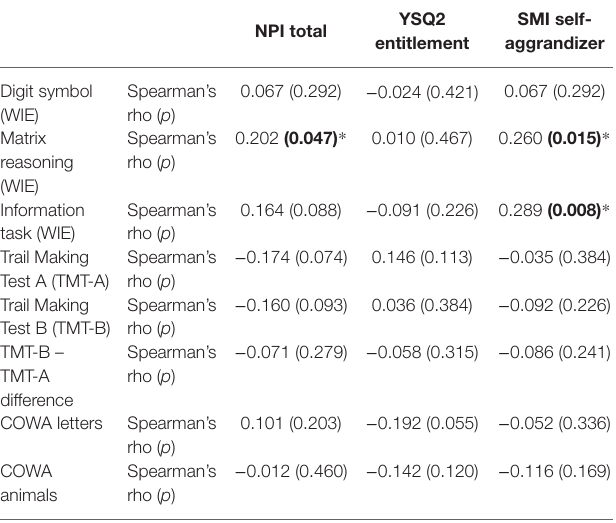
TABLE 2 | Exploratory correlation analysis of narcissism measures NPI (narcissistic personality inventory, 40-item version), YSQS2 entitlement scale and SMI self-aggrandizer scale with other cognitive measures, not directly/specifically tapping working